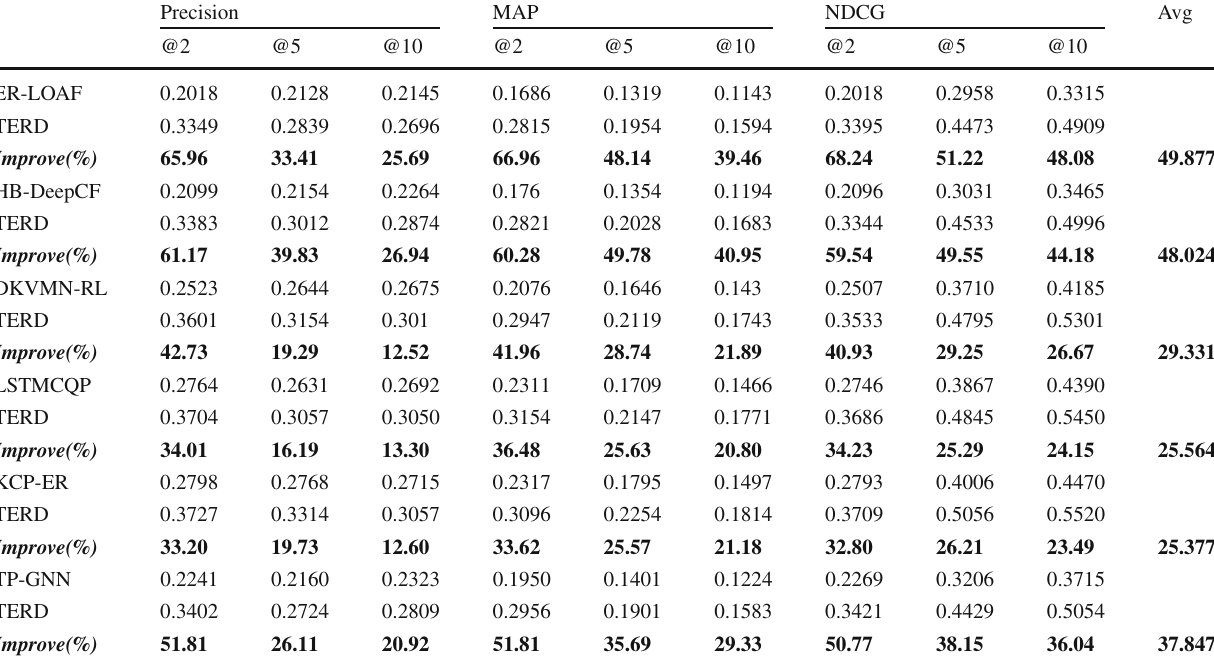
Table 4 Results of comparison among six algorithms with and without adding teacher network on Algebra0506 dataset Precision